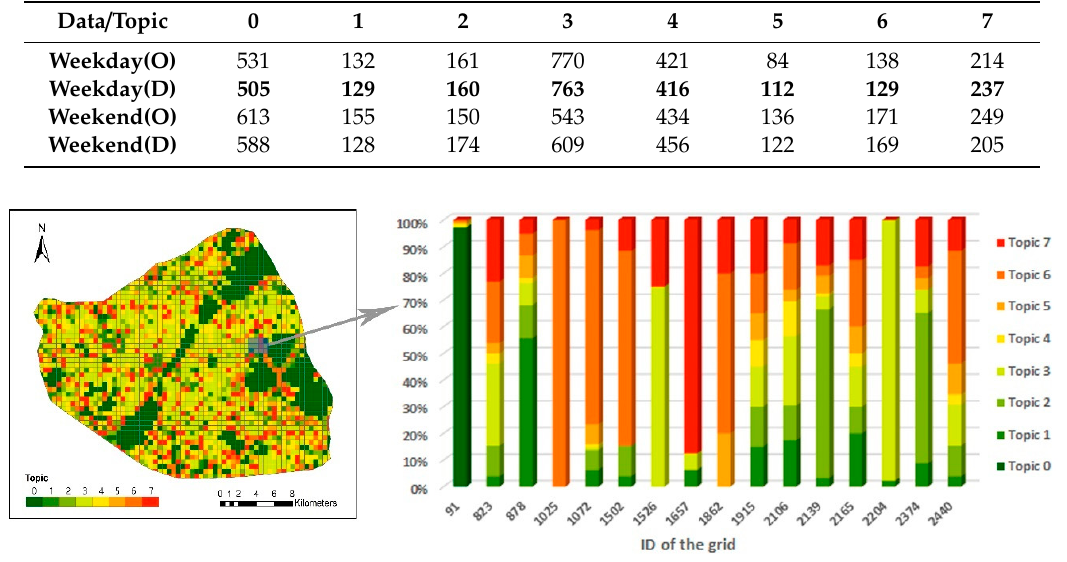
Figure 6. Topic distribution under four groups of data: ( a ) O point of weekday; ( b ) D point of weekday; ( c ) O point of weekend; and ( d ) D point of weekend. Table 2. Topic distribution under four groups of data.